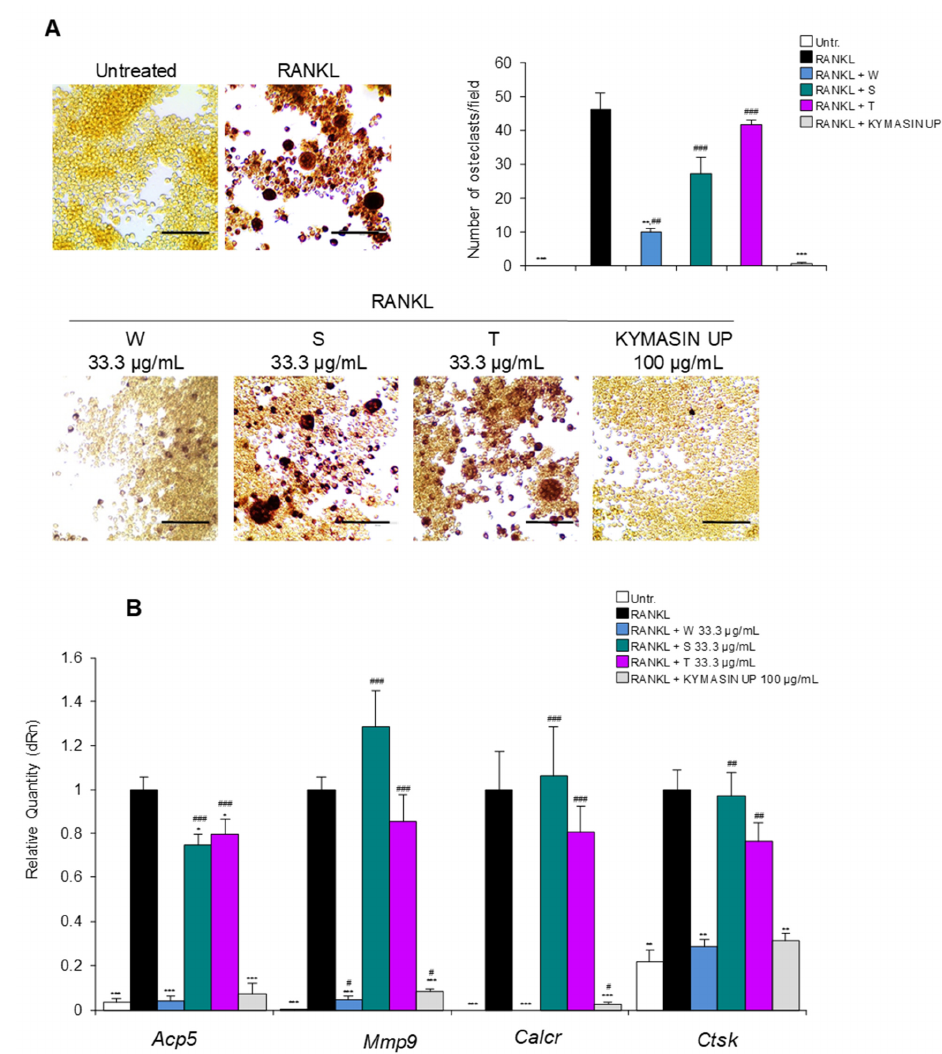
Figure 3. ( A , B ) RAW 264.7 cells were treated for 5 days with RANKL in the absence or presence of W. somnifera (W), S. marianum (S), T. foenum-graecum (T) or KYMASIN UP at the indicated concen- trations. ( A ) TRAP staining was performed and representative images are reported. The numbers of TRAP-positive OCs ( ≥ 3 nuclei) were determined. ( B ) Real-time PCR analysis of Acp5 , Mmp9 , Calcr , and Ctsk was performed. Gene expressions were normalized to Gapdh . Results are means ± standard deviation ( A , B ). Three independent experiments were performed. Statistical analysis was conducted using the two-tailed t -test. * p < 0.05, ** p < 0.01, and *** p < 0.001, significantly different from RANKL. # p < 0.05, ## p < 0.01, and ### p < 0.001, significantly different from untreated control (Untr). Scale bars ( A ), 100 µm.